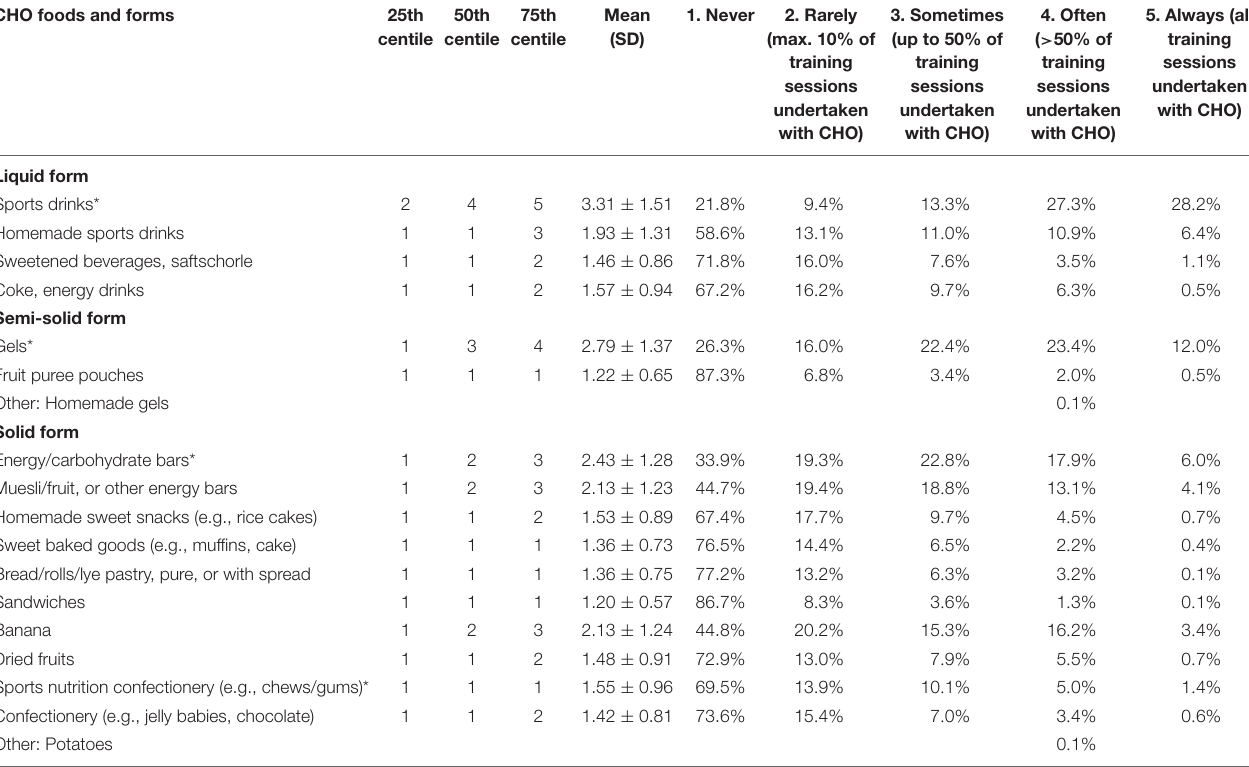
TABLE 2 | Intake frequencies of carbohydrate foods in endurance participants ( n = 1,077) during training at high intensities. CHO foods and forms